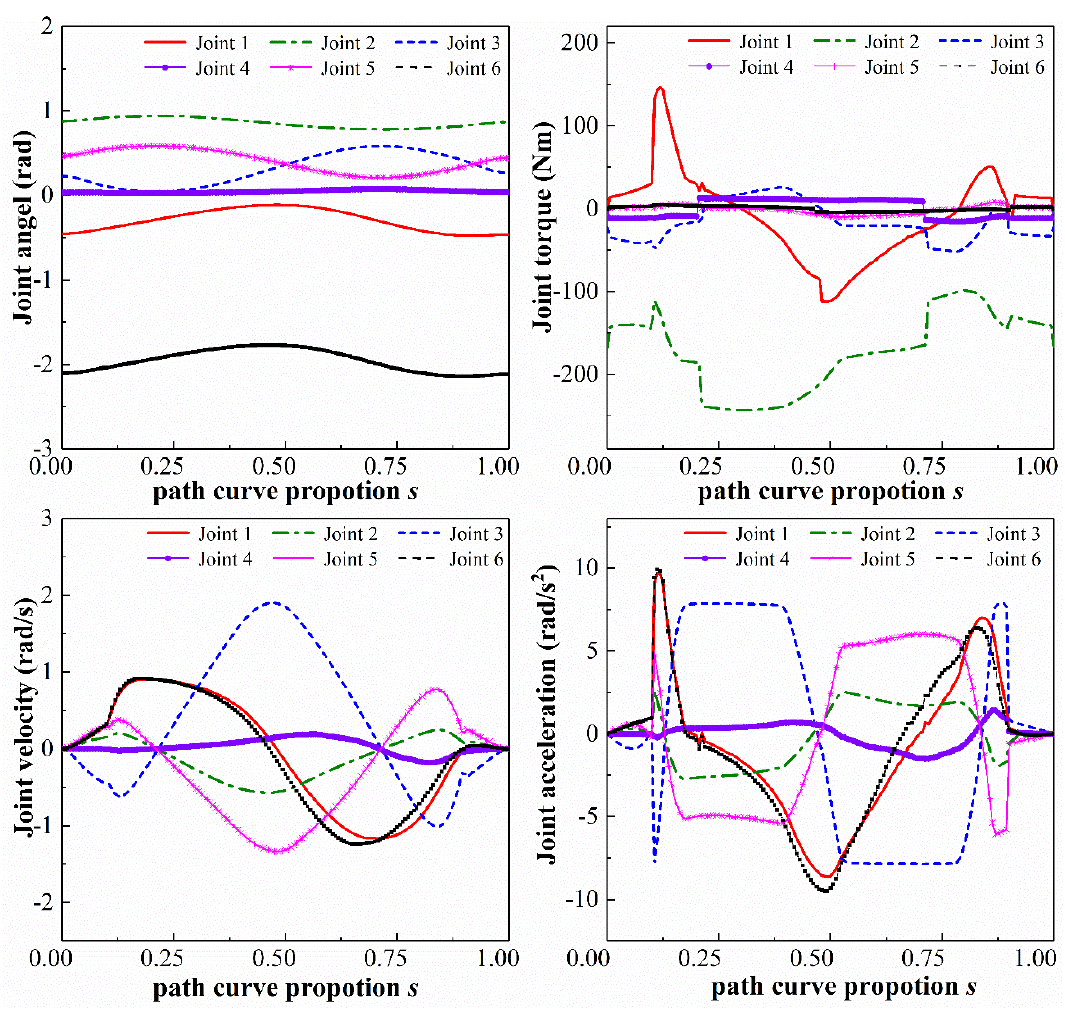
Figure 8. Optimized trajectories for robot joint with the proposed method when α = 1.